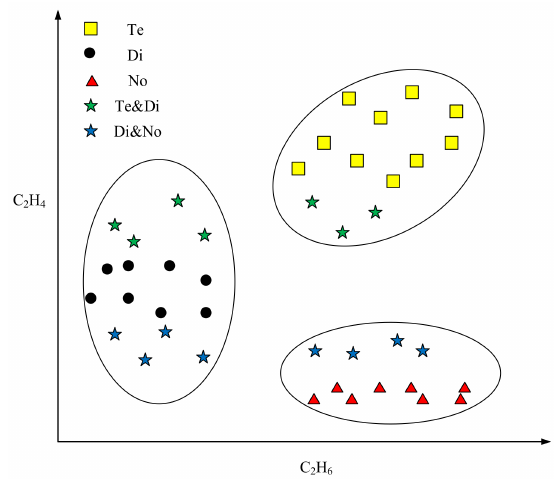
Figure 1. The presentation of three states of the transformer. No: normal state; Te: temperature fault; Di: discharge